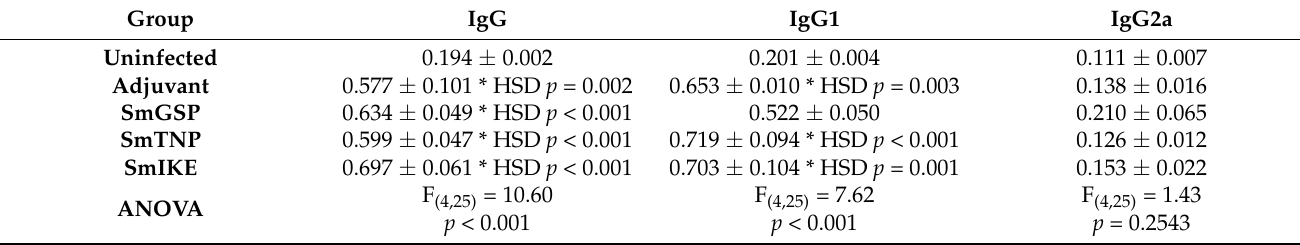
Table 3. Specific IgG levels by indirect ELISA against SoSmAWA antigen in BALB/c mice vaccinated with SmGSP, SmTNP and SmIKE formulated in the ADAD vaccination system with immunomodulator AA0029 at eight weeks post- S. mansoni challenge. * Statistically significant differences ( p < 0.05) were determined by analysis of variance (ANOVA) and post hoc Tukey’s test